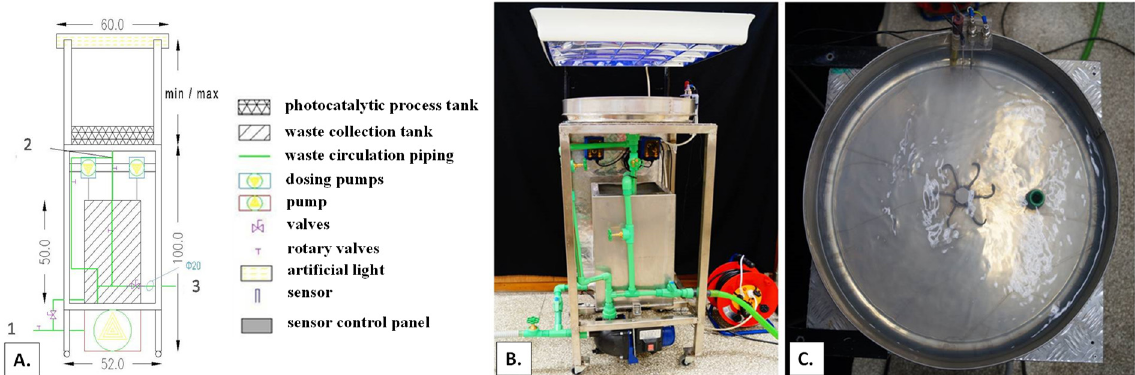
Figure 9. ( A ) Schematic diagram of the fountain ‐ type pilot photocatalytic reactor operating under artificial illumination (UV ‐ A or visible) (front view); ( B ) photo of the fountain ‐ type pilot photocatalytic reactor; ( C ) top view of the photocatalytic treatment tank. The six nozzles through which the waste enters the tank and the hole/pipe through which the waste overflows and returns to the waste collection tank can be distinguished.